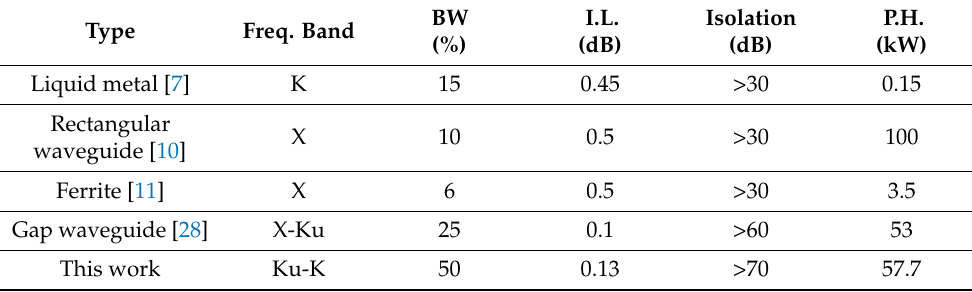
Table 1. Comparison between published works and the proposed switch. Type Freq.